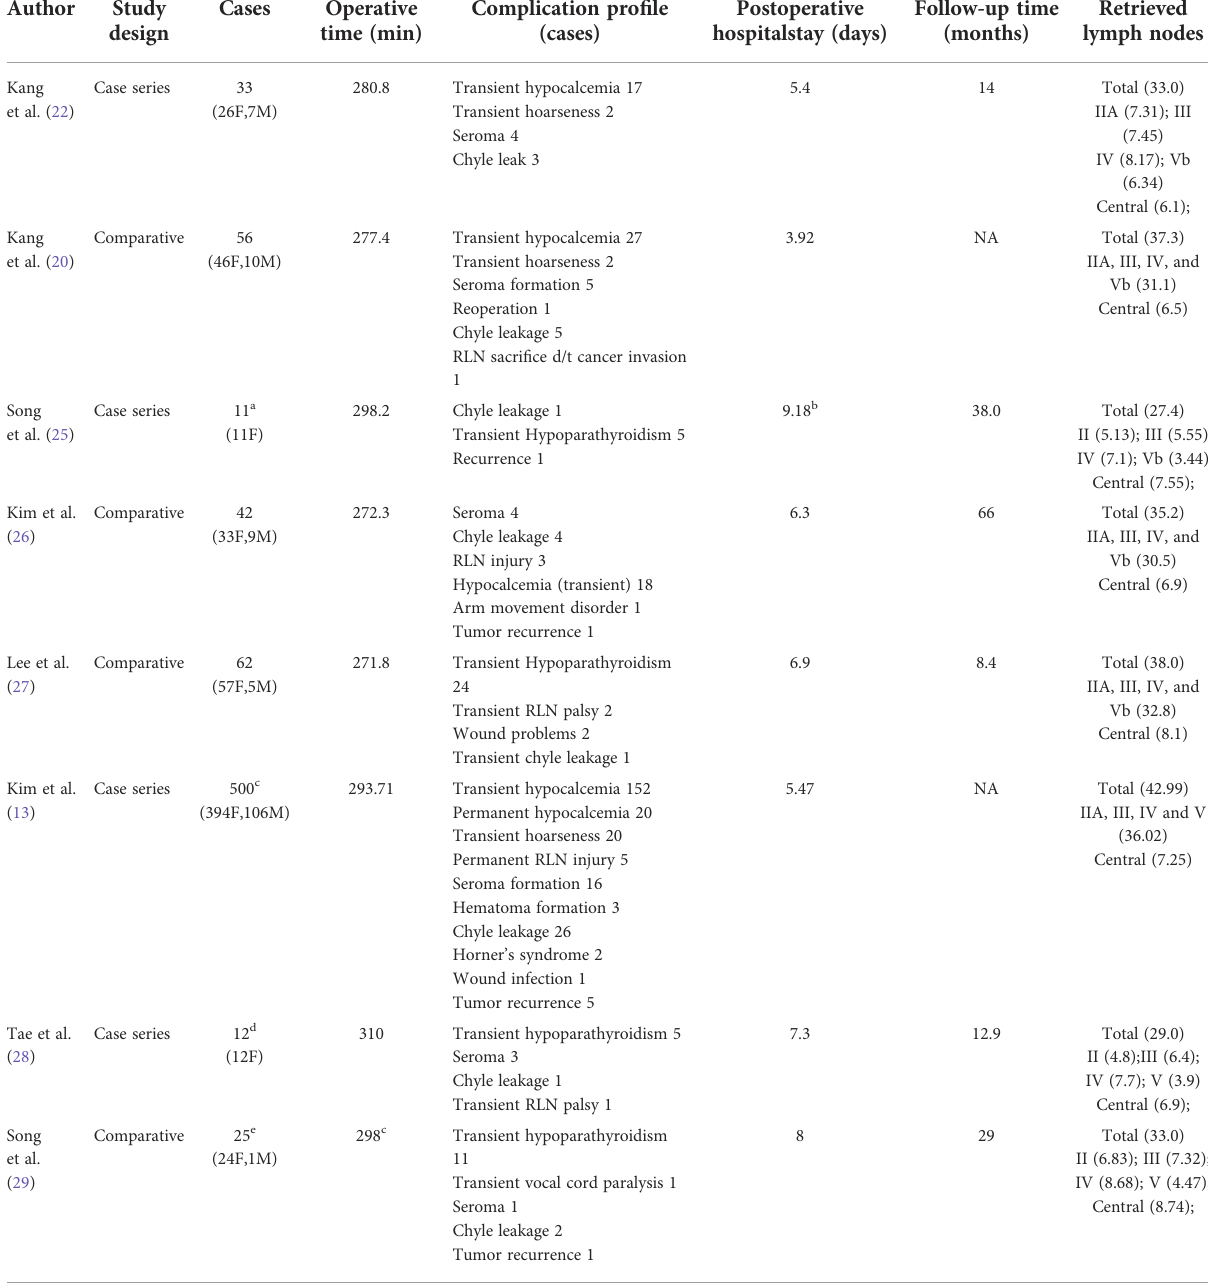
TABLE 2 Summary of studies of robotic transaxillary